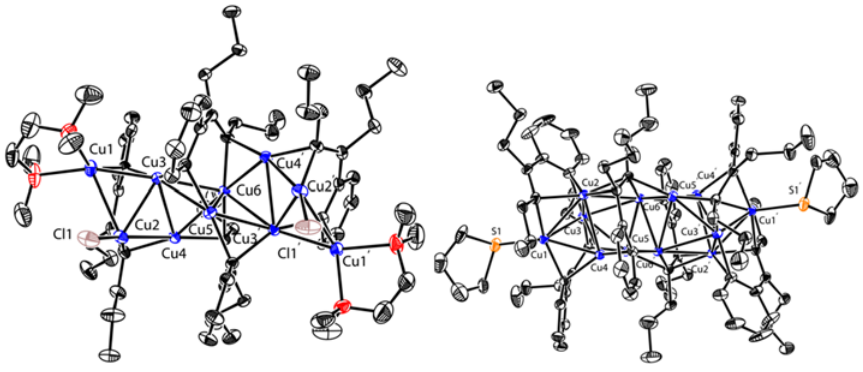
Figure 7. Molecular structures of 53 and 54 ; drawn based on [57].